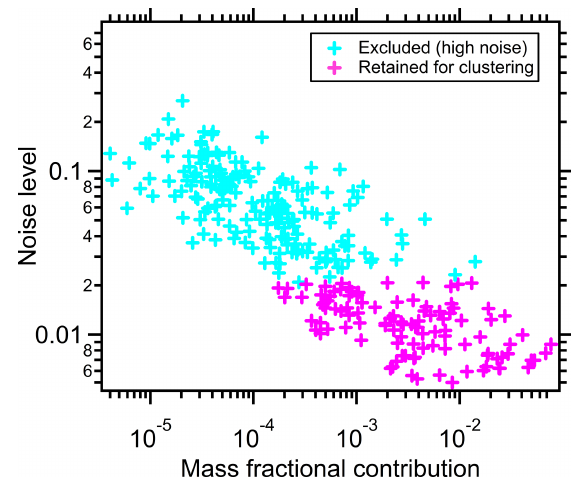
Figure 1. The relationship between thermogram noise levels and the fractional contributions of the corresponding ions to total mass for α -pinene + OH SOA. The noise threshold, ξ ref = 0 . 021, is used to distinguish high-noise thermograms (cyan markers) from ther- mograms having acceptable noise levels (pink